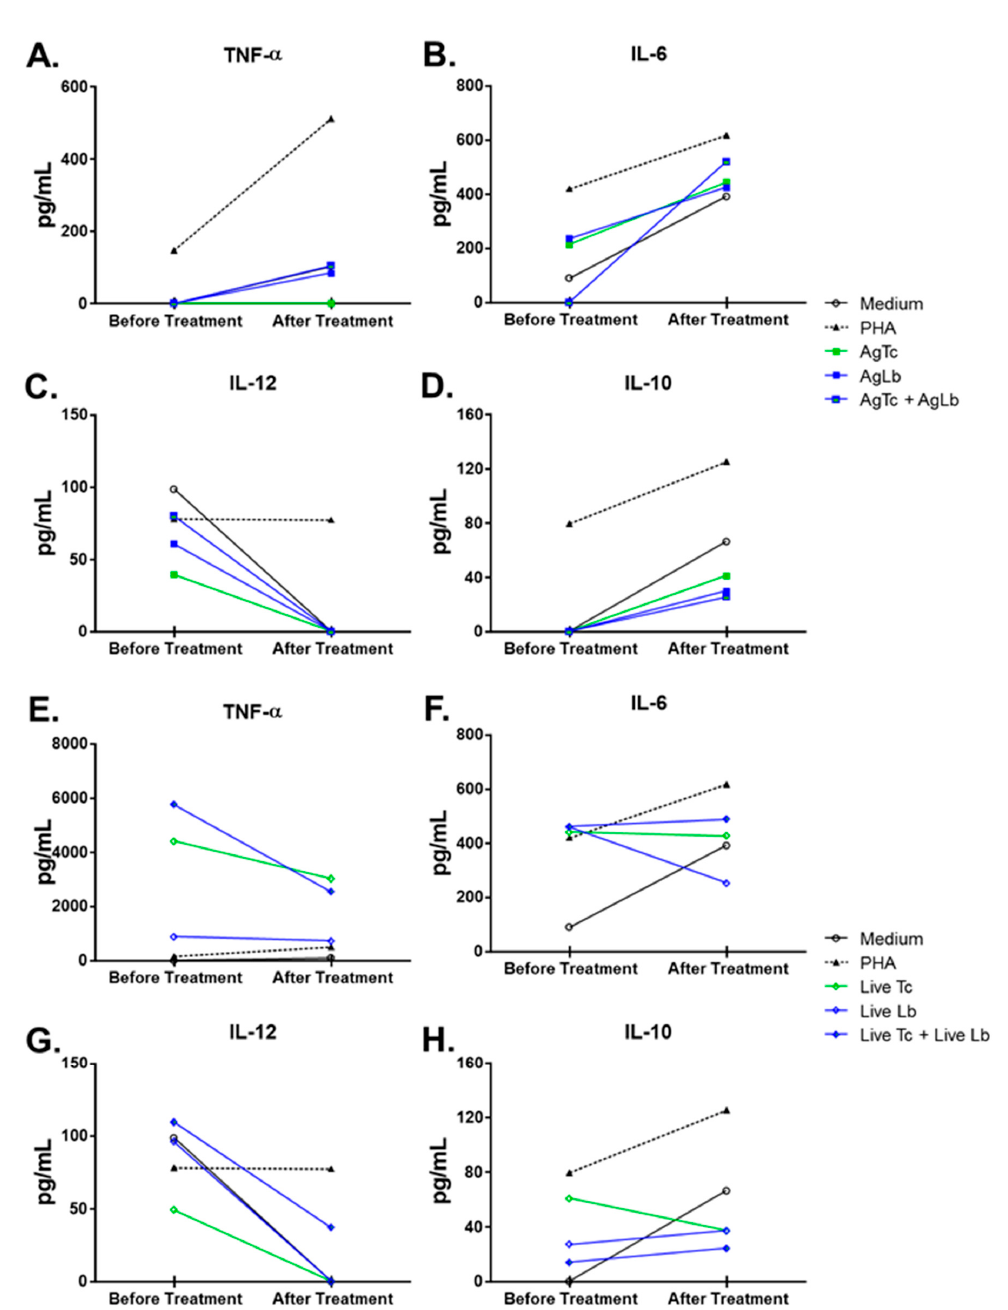
Figure 2. Cytokine’s production by peripheral blood mononuclear cells (PBMC) stimulated in vitro before and after patient’s treatment with meglumine antimoniate. Graph ( A – D ) depicts the level of ( A ) TNF- α ; ( B ) IL-6; ( C ) IL-10, and ( D ) IL-12 detected by ELISA in culture supernatants before and after treatment. Graphs ( E – H ) depict the fold induction capacity of antigens and live parasites on cytokine production over basal stimulation (medium alone). Open bars represent results before treatment and full bars represent results after